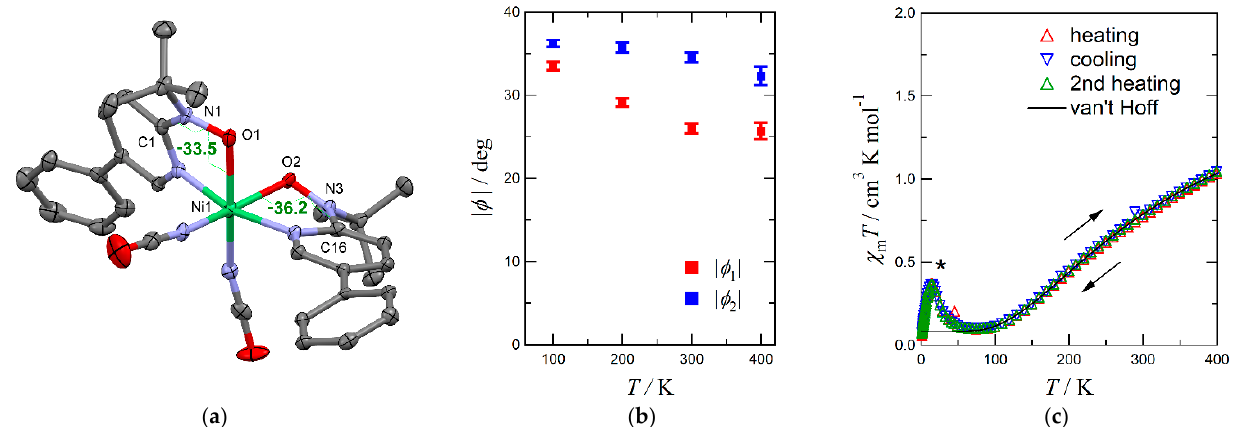
Figure 11. ( a ) X-ray crystal structure of [Ni(phpyNO) 2 (NCO) 2 ] measured at 100 K. Hydrogen atoms are omitted. Thermal ellipsoids are drawn at the 50% probability level. Selected atomic numbering and torsion angles ( φ (Ni–O–N–C sp 2 )) are indicated. ( b ) Temperature dependences of torsion angles (| φ |) and ( c ) χ m T for [Ni(phpyNO) 2 (NCO) 2 ]. An asterisk indicates impurity signal in ( c ). Adapted from [122], published by MDPI, 2020.